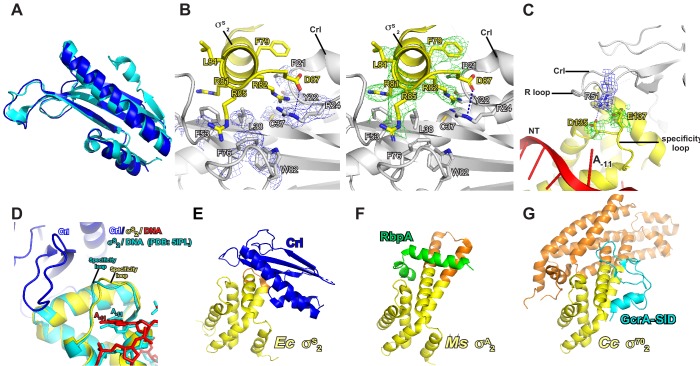
The detailed interactions between Crl and σS2.(A) Structure superimposition of Crl proteins from crystal structure of Crl (PDB: 4Q11; cyan) and Crl in E. coli Crl-TAC (blue). (B) The σS2 inserts into a hydrophobic groove on surface of Crl. (C) The interaction between the ‘R’ loop of Crl and the ‘specificity’ loop of σS2. The cryo-EM density maps for the side chains of the interface residues of Crl and σS2 are shown as in blue and green mesh, respectively. The C, N, and O atoms of Crl residues are shown in white, blue, and red, respectively. The C, N, and O atoms of σS residues are shown in yellow, blue, and red, respectively. (D) Structure superimposition of our E. coli Crl–σS–RPo complex and E. coli σS–RPo complex (PDB 5IPM) reveals similar conformation of the specificity loop. (E) E. coli Crl interacts with σS2 in our structure. (F) Mycobacterium smegmatis RbpA interacts with σA2 in PDB 5TW1. (G) Caulobacter cresentus GcrA interacts with σ702 in PDB 5YIX. The conserved region and the non-conserved region (NCR) of σS2 in (E), (F), and (G) are shown in yellow and orange, respectively.